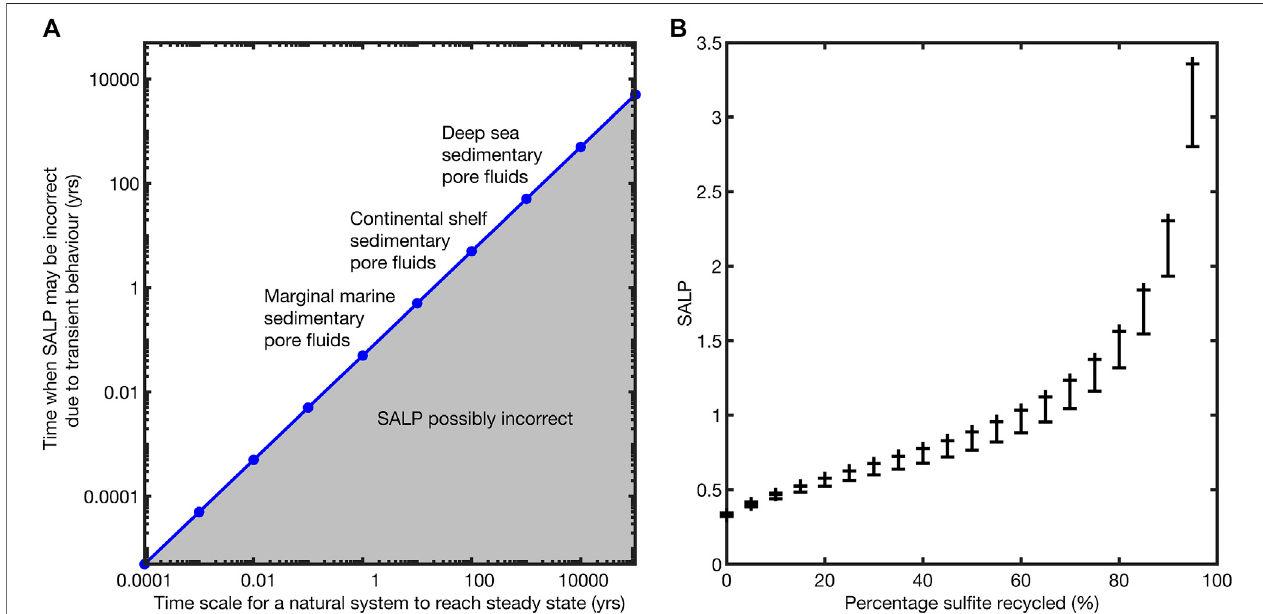
FIGURE 6 | Left, (A) ; a schematic plot showing the time scales over which the measurement of the SALP may be unreliable. Our modeling suggests that this is approximately the fi rst 5% of the total time to steady state and that this effect is scale independent. Right, (B) ; a plot of the SALP and the maximum error in its measurement as a function of the percentage recycling taking place. The error bars represent the maximum deviation of the SALP from its steady state value during its approach to steady state, ignoring the fi rst 5% of equilibration time in which the SALP is many orders of magnitude wrong, see equilibration behavior in Figure 5